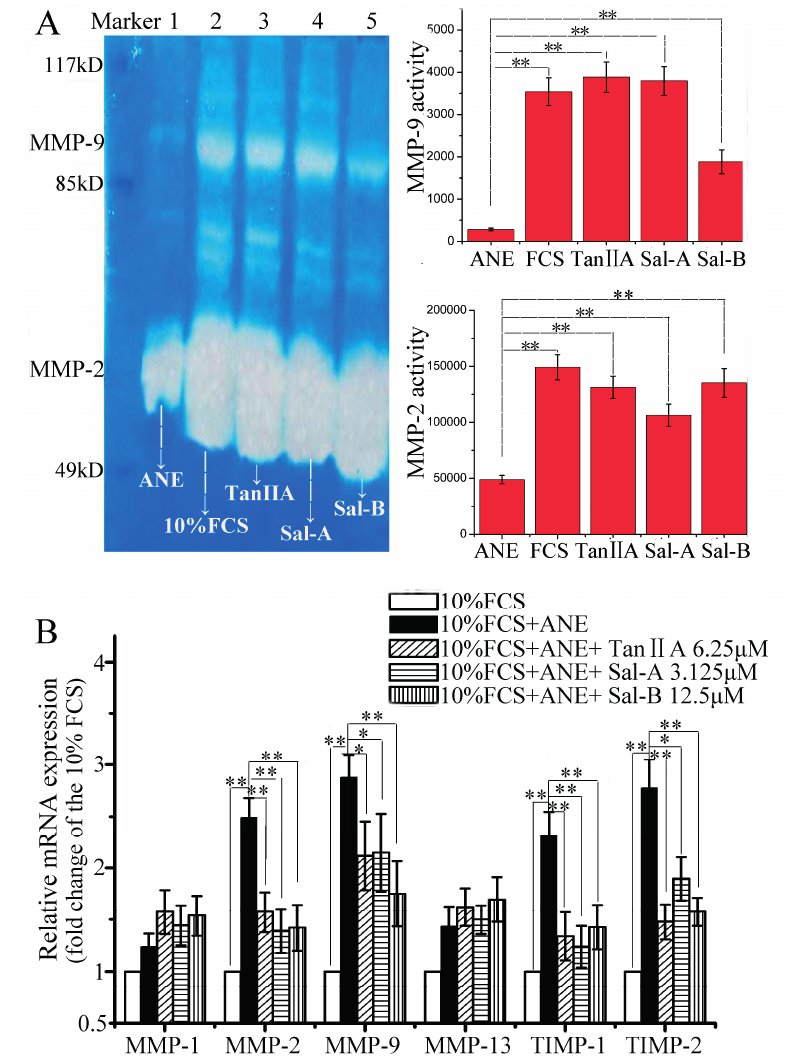
Figure 3. Effect of Tan-IIA, Sal-A and Sal-B on MMP activity and TIMP expression after ANE treatment. ( A ) Effect of Tan-IIA, Sal-A and Sal-B on MMP-2/-9 activity (left: the graph of the gelatin zymography assay; right: the statistical results). MOMFs were cultured in 10% FCS DMEM medium with or without ANE (12.5 μ g/mL) and simultaneously treated with or without Tan-IIA (6.25 μ M), Sal-A (3.125 μ M) and Sal-B (12.5 μ M). Lane 1 (ANE-only treated control): FCS + ANE; Lane 2 (blank control): FCS; Lane 3 (Tan-IIA-treated group): FCS + ANE + Tan-IIA; Lane 4 (Sal-A-treated group): FCS + ANE + Sal-A; Lane 5 (Sal-B-treated group): FCS + ANE + Sal-B. n = 3, ** p < 0.01 vs. the ANE only-treated control. ( B ) Effect of Tan-IIA, Sal-A and Sal-B on the expression of MMP-1, MMP-2, MMP-9, MMP-13, TIMP-1 and TIMP-2 by qRT-PCR assay; the result was shown as the fold change of the 10% FCS group. n = 5, * p < 0.05 and ** p < 0.01 vs. the FCS + ANE